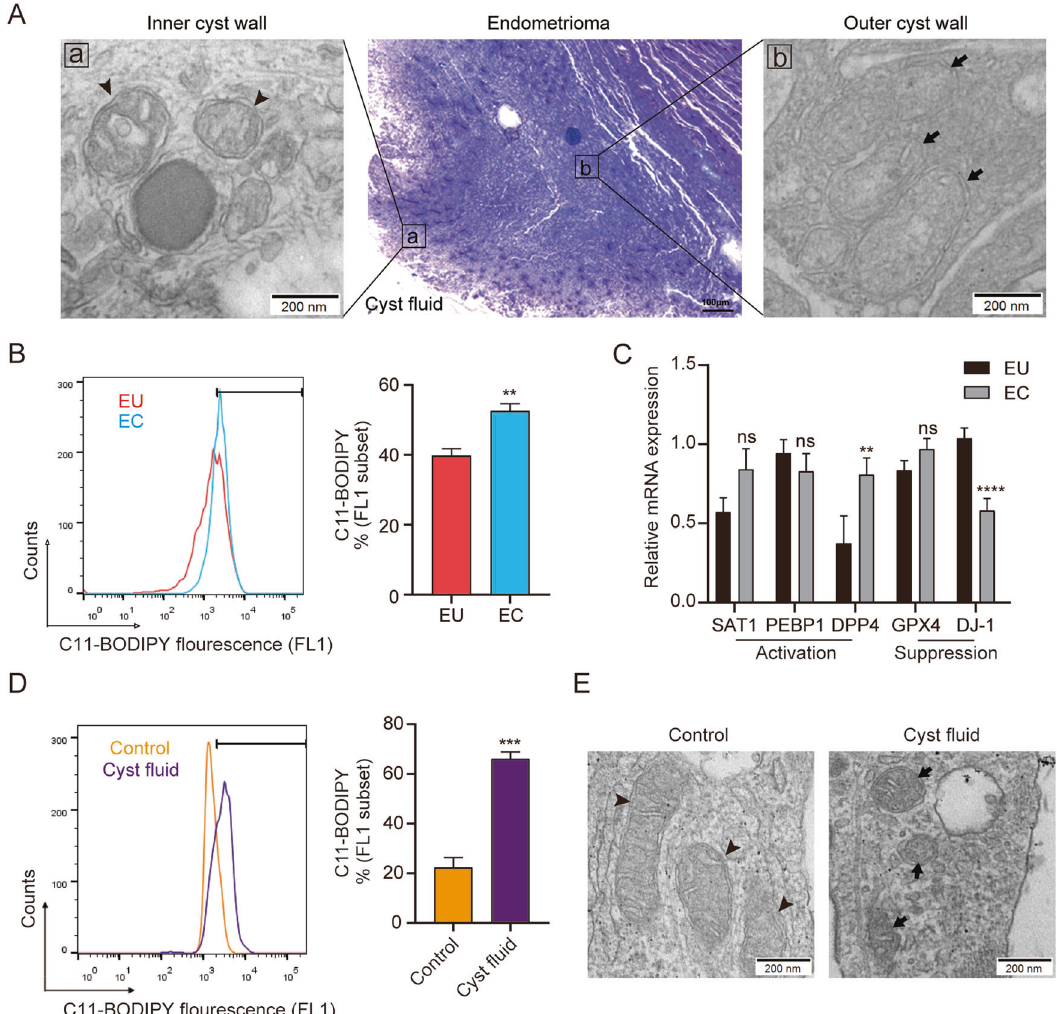
Fig. 1 Ferroptosis detection in endometriosis. A Representative transmission electron microscopy images of the ultrastructure of the inner and outer walls of mitochondria of endometrioma. B Single stromal cells were isolated from the paired eutopic and ectopic endometria and their lipid ROS accumulation was assayed using fl ow cytometry and C11-BODIPY. Representative data and statistical analyses from fi ve independent experiments are shown. C The relative mRNA expression levels of three upregulated (SAT1, PEBP1, and DPP4) and two downregulated (GPX4 and DJ-1) ferroptosis-related genes were compared between the paired eutopic and ectopic endometria ( n = 24). D , E ESCs were cocultured with diluted cyst fl uid (1:1) for 12 h in vitro. The lipid ROS levels were examined and transmission electron microscopy of mitochondria ultrastructure was analysed. Arrowheads indicate deformed mitochondrial structures, while arrows point to normal mitochondrial structures. Comparisons were made using the two-tailed, Student ’ s t test ( B – D ). ** P < 0.01, *** P < 0.001, **** P < 0.0001. ns not statistically signi fi cant, EU eutopic endometrium from patients with endometriosis, EC ectopic lesions from patients with endometriosis, GPX4 glutathione peroxidase 4, SAT1 spermidine/spermine N1-acetyltransferase 1, PEBP1 phosphatidylethanolamine-binding protein 1, DPP4 dipeptidyl-peptidase-4, ESCs endometrial stromal cells, ROS reactive oxygen